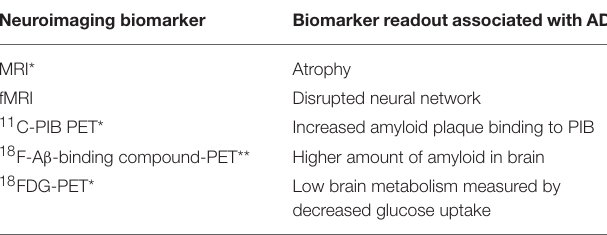
TABLE 1 | Neuroimaging biomarkers in Alzheimer’s